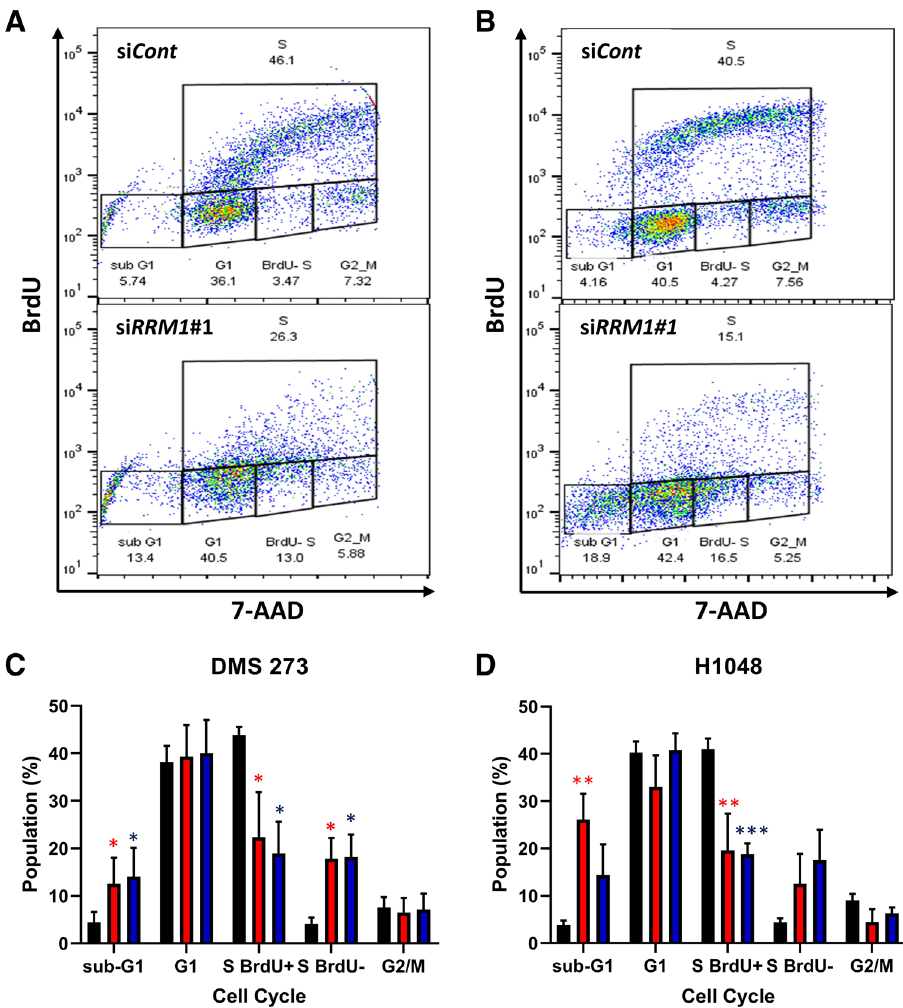
Figure 4. RRM1 knockout stalls DNA replication and induces cell cycle arrest. ( A ) and ( B ), representative flow cytometry cell cycle data for siRNA-treated 273 ( A ) and H1048 (B) cells after double staining for BrdU incorporation (S phase cells) and 7-AAD (DNA content). ( C ) and ( D ), cell cycle analysis of DMS 273 ( C ) and H1048 ( D ) SCLC cells transfected with si RRM1 showing the percentage of cells in sub-G1, G1, S (BrdU −), S (BrdU +), and G2/M phase. Black: siCont, red: si RRM1 #1, blue: si RRM1 #3. Data represent the mean ± SD ( n = 4). * p < 0.05, ** p < 0.01, *** p < 0.005 vs. control, Dunnett’s multiple comparisons